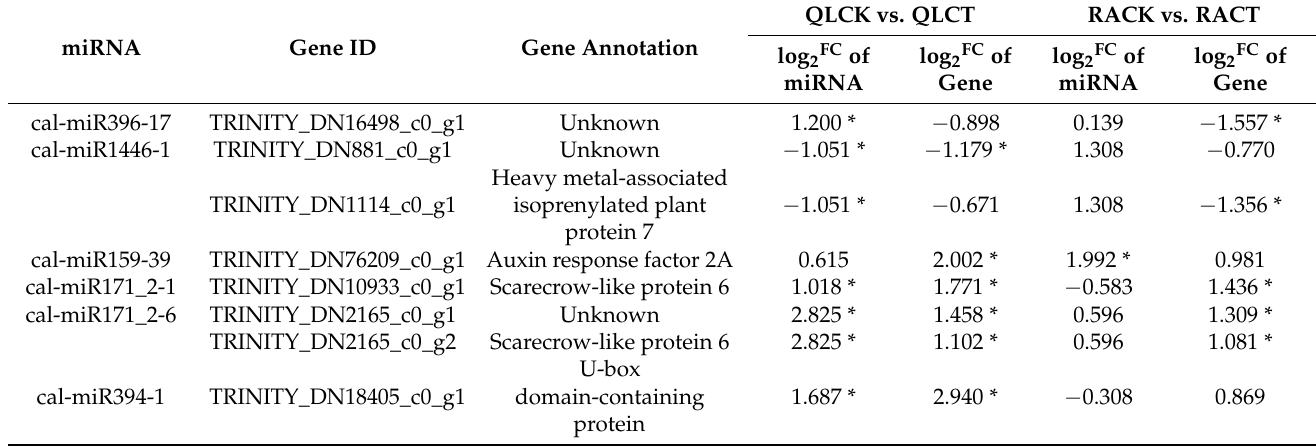
Table 9. Differentially expressed target genes of DEMs after low temperature stress treatments.